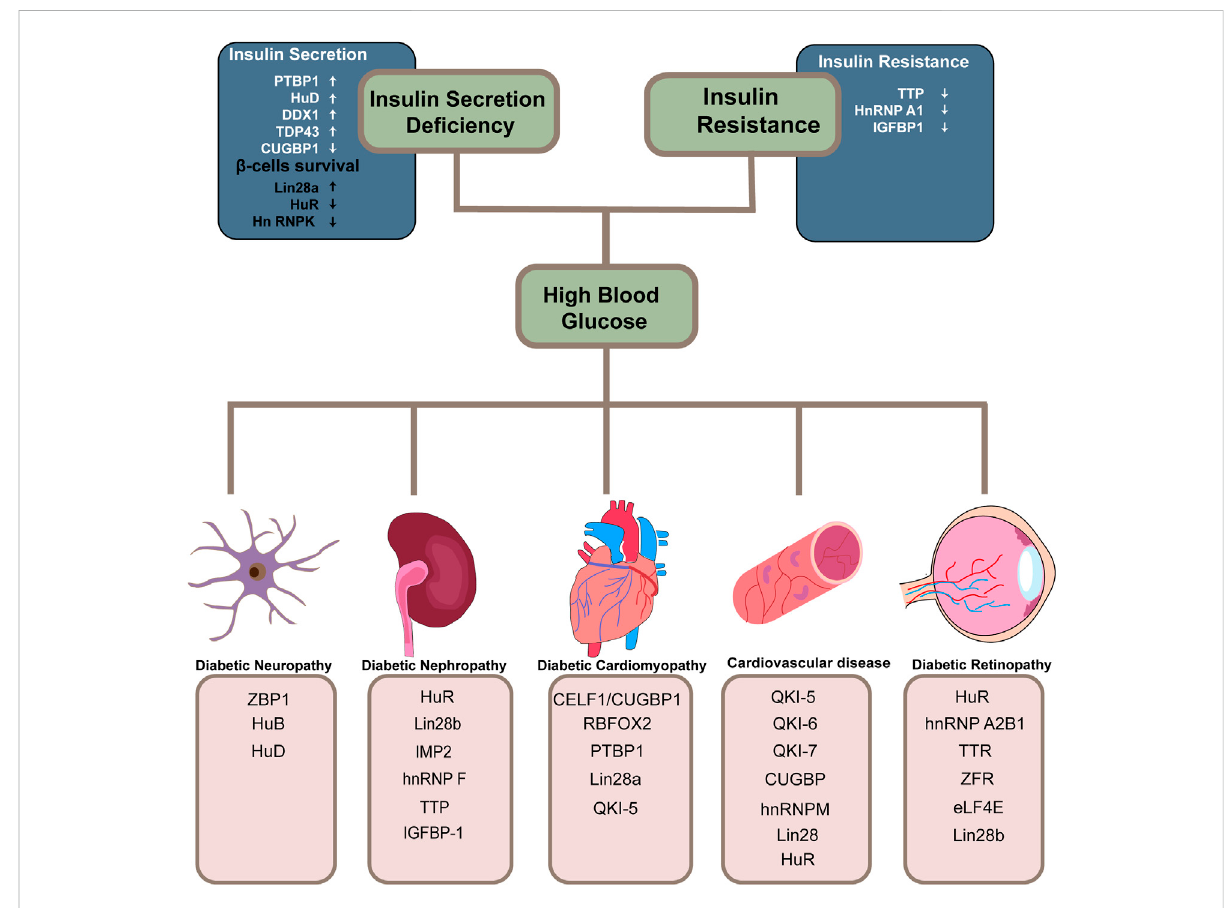
FIGURE 2 OverviewofRBPs involved indiabetes anditsrelatedsystematiccomplications.RNA-binding proteinsimplicatedinthetwodecisive linksinthe progression of diabetes and its related systematic complications are summarized. The arrows in the diagram point to either protective effects or the